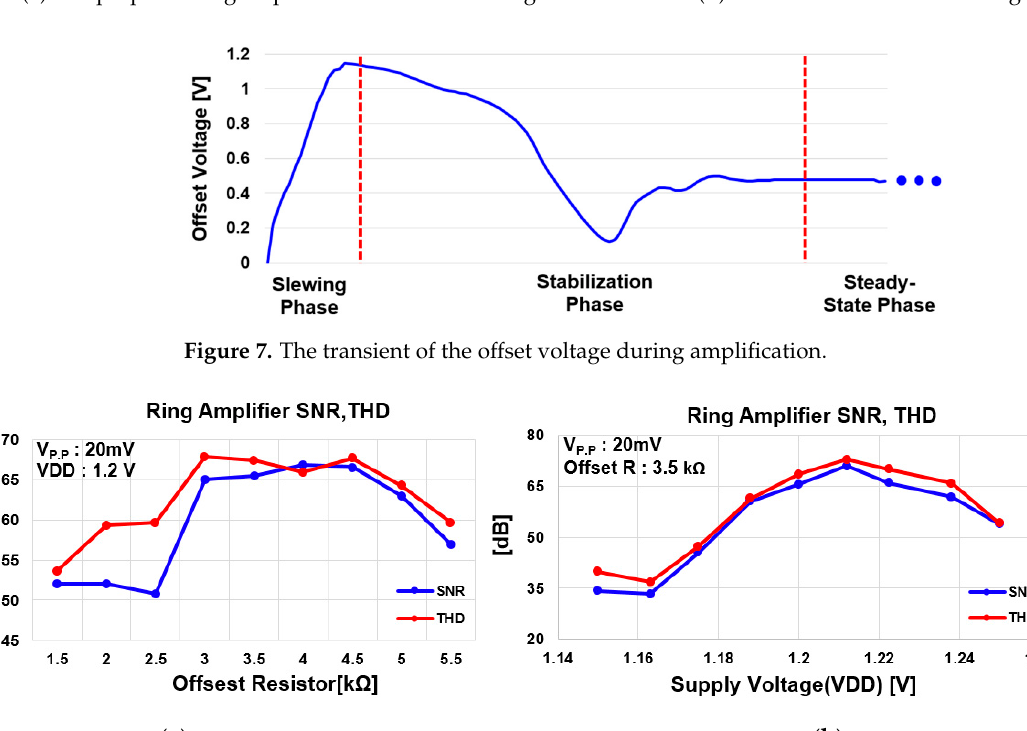
Figure 6. ( a ) The proposed ring amplifier structure in the single-ended mode. ( b ) The CMFB circuit with a single loop.